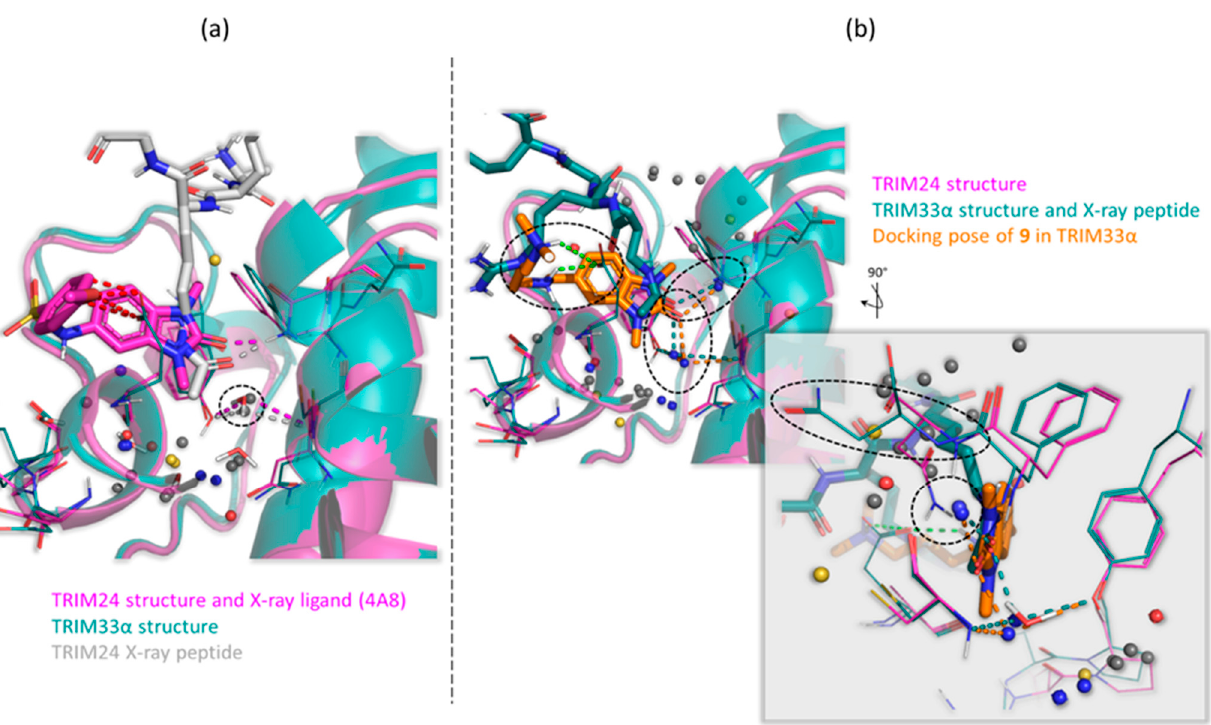
Figure 10. Prediction of the water molecules in the KAc binding site of TRIM24 and TRIM33 α . The aligned structures of TRIM24 (PDB code: 4yat [42] in magenta) and TRIM33 α (PDB code: 3u5o [39] in teal) are reported. The coloured spheres represent the predicted water molecules using Water- FLAP. The colour is related to their predicted free energy value ( ∆ G): RED for “Very unhappy” water ( ∆ G ≥ 3.0 kcal/mol); YELLOW for “Unhappy” water (1.5 kcal/mol ≤ ∆ G < 3.0 kcal/mol); GREY for “Solvent-like” water ( − 2.0 kcal/mol ≤ ∆ G < 1.5 kcal/mol); BLUE for “Happy” water ( ∆ G < − 2.0